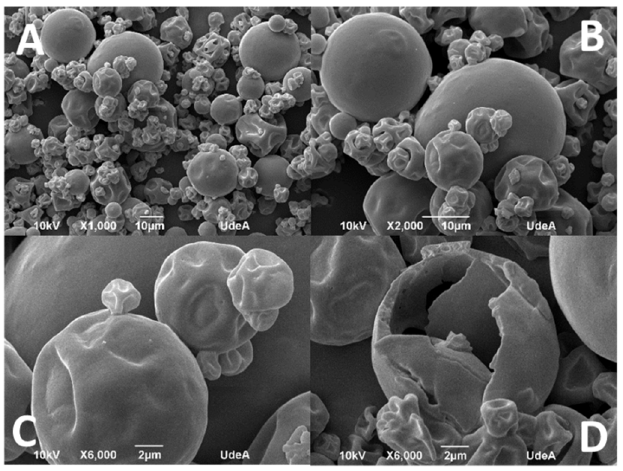
Figure 2. ( A ) X 1000; ( B ) X 2000; ( C ) X 6000; ( D ) the microcapsule’s internal morphology.